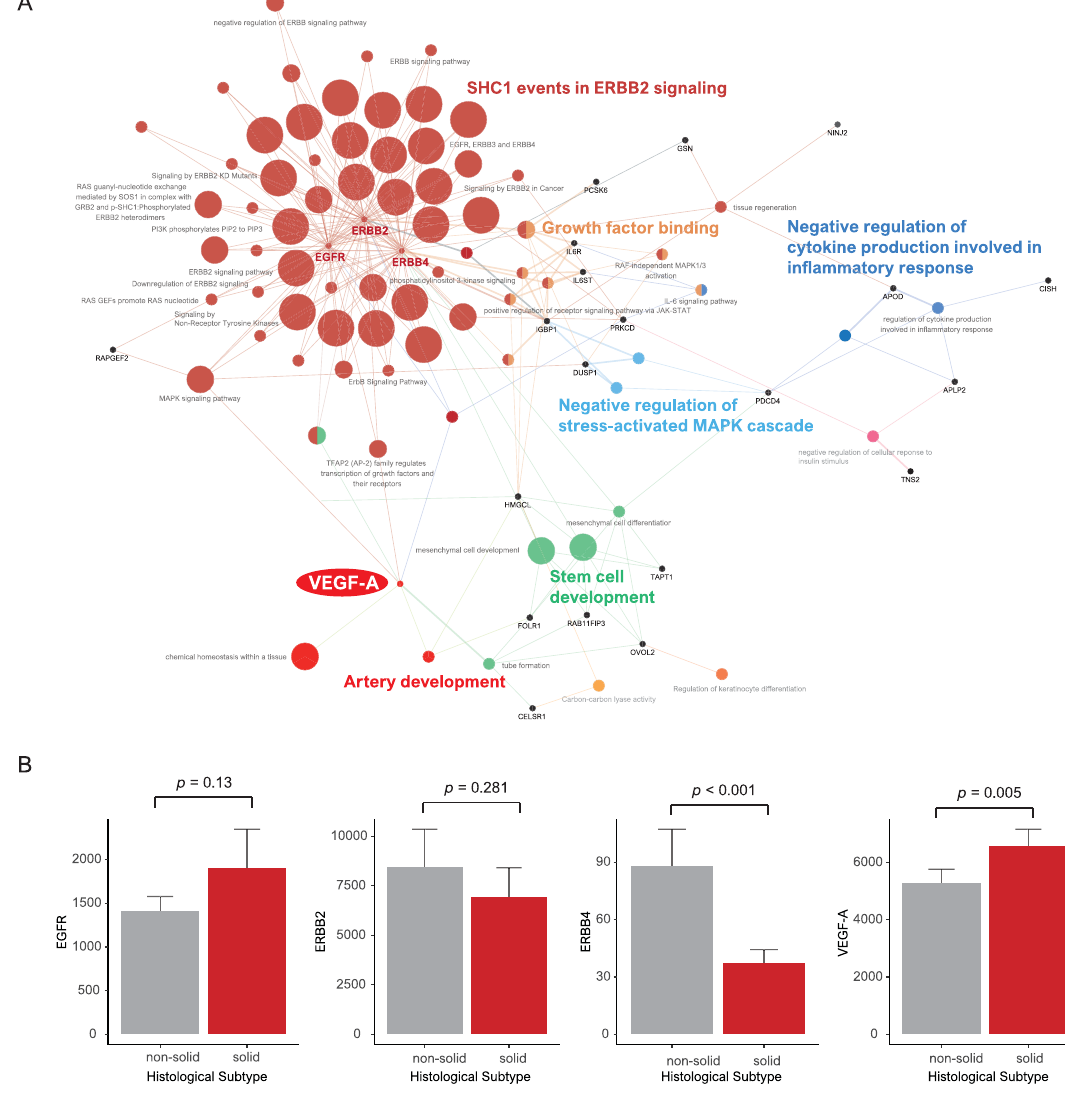
Figure 4. ( A ) Grouping of networks based on functionally enriched Gene Ontology (GO) terms and pathways in the solid type. The functionally grouped networks are linked to their biological function, where only the most significant term in the group is labeled. ( B ) Bar plots of EGFR, ERBB2, ERBB4 and VEGF-A ( p = 0.13, 0.281 < 0.001 and 0.005,